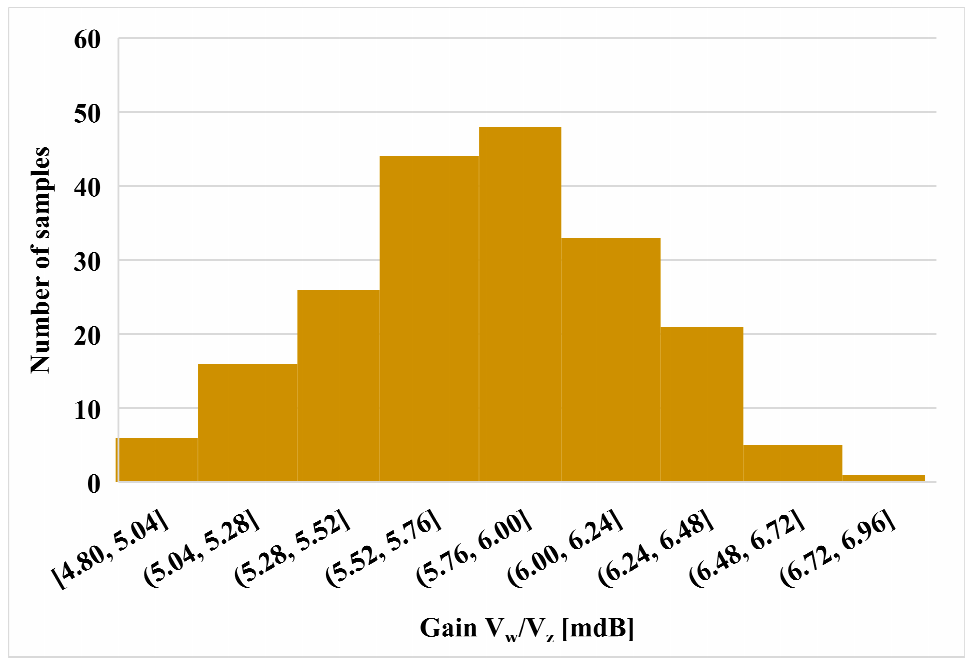
Figure 10. A histogram of the voltage gain V w / V z with 200 runs MC analysis .